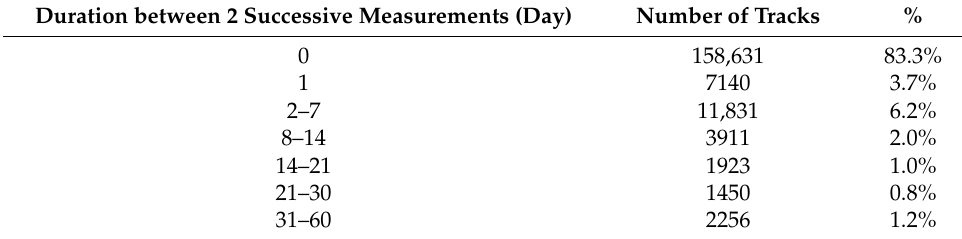
Table 9. Duration between two successive measurements for users who have more than one contribution. Duration between 2 Successive Measurements (Day) Number of